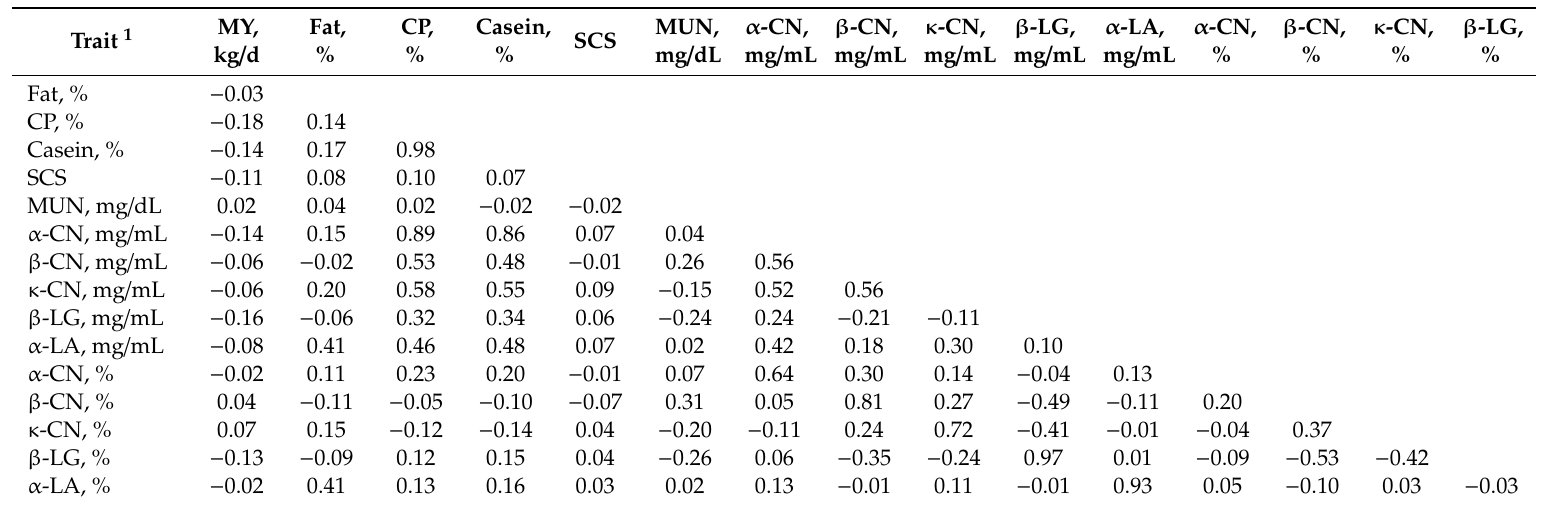
Table 3. Pearson correlations, calculated using linear model residuals, between milk yield (MY), milk composition, somatic cell score (SCS), milk urea nitrogen (MUN), and detailed protein composition of cow